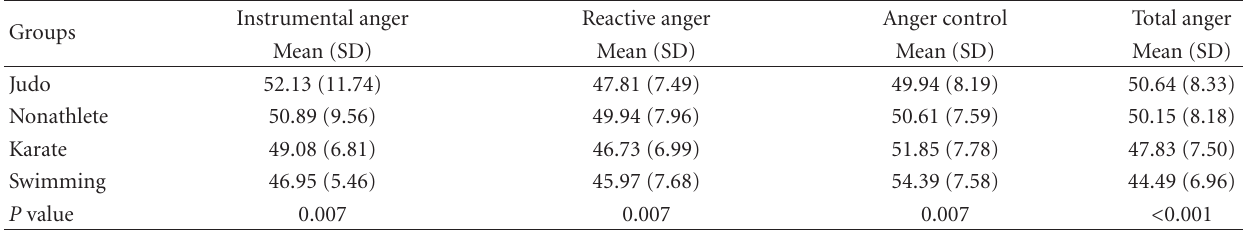
Table 2: Total anger scale and anger subscales scores by type of